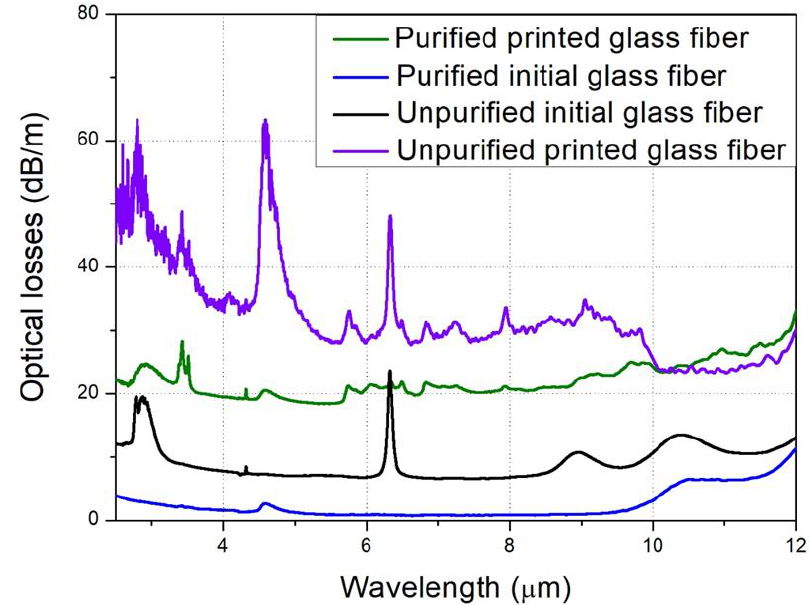
Figure 6. Attenuation spectra of the initial glasses (unpurified and purified glasses, red curve and blue curve respectively) and the “printed” glass fibers (from an unpurified glass and from a purified glass, purple and green respectively)